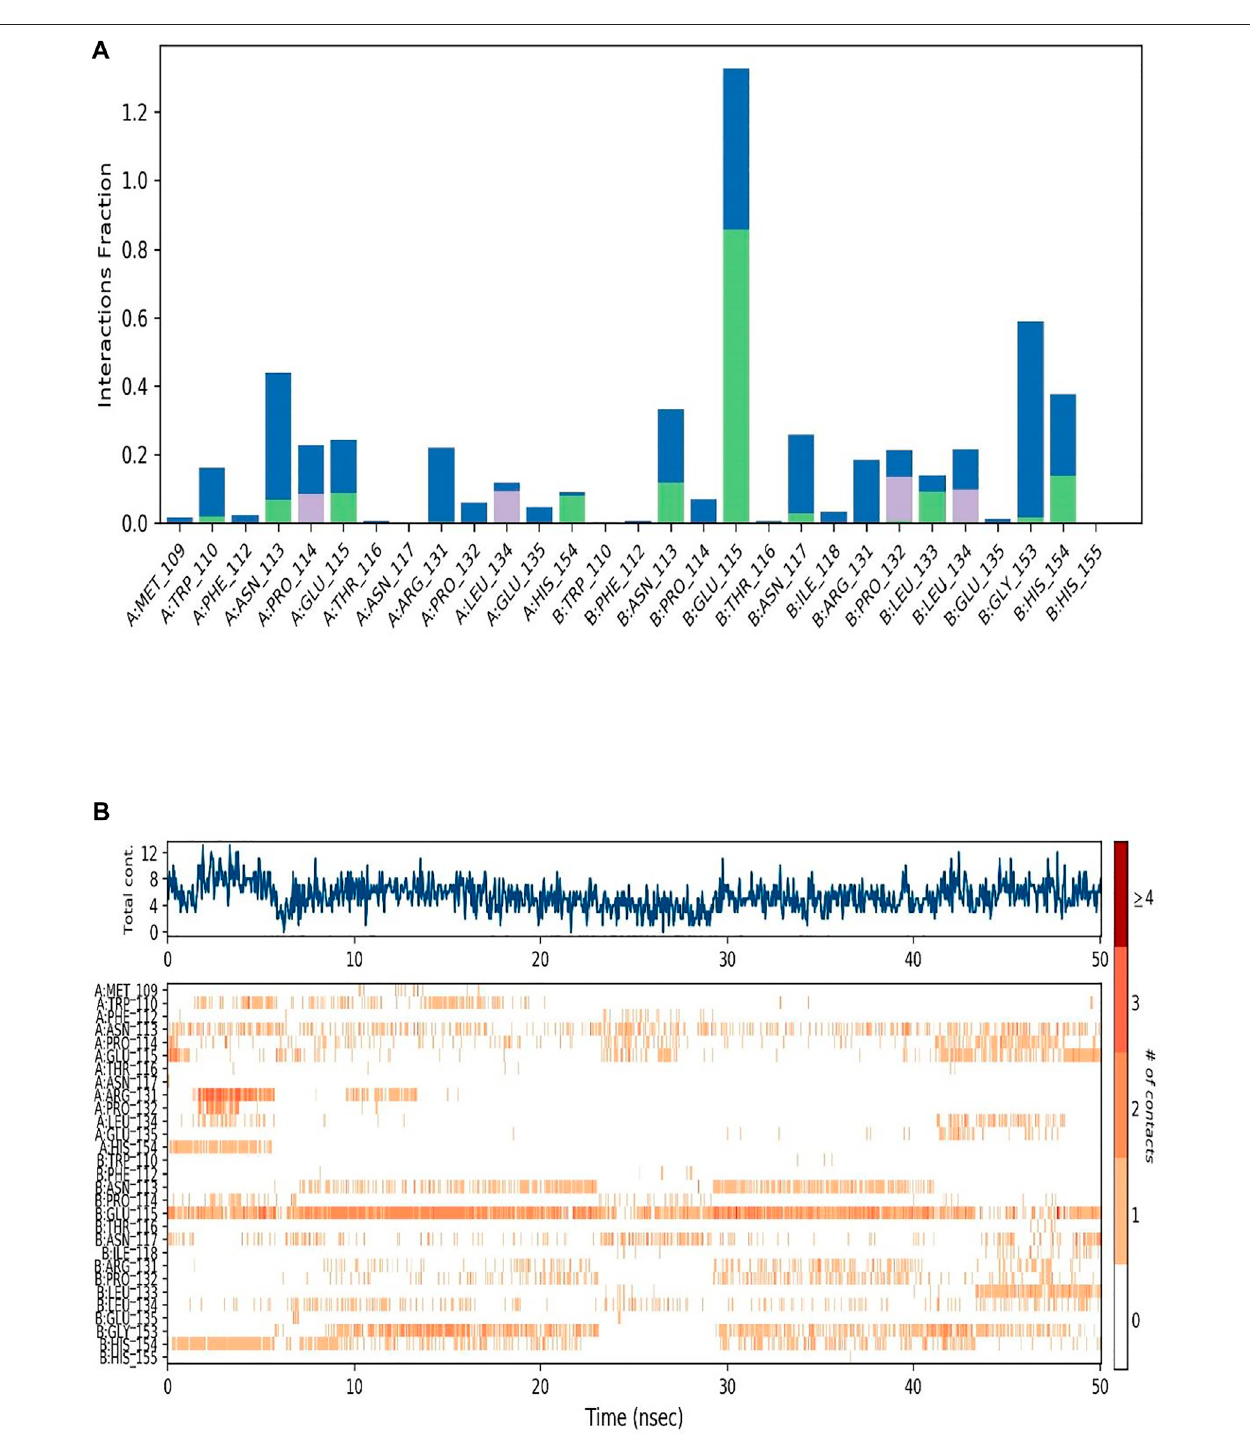
FIGURE 4 | (A) InteractionsbetweentheSARS-CoV-2MproteinandtheLigandthroughouttheSimulationisdepictedinbars.Differentcolorsigni fi esdifferentinteractions and contacts formed between the amino acids and the ligand atoms. (B) Graphical representation of the interactions and contacts throughout the Simulation.